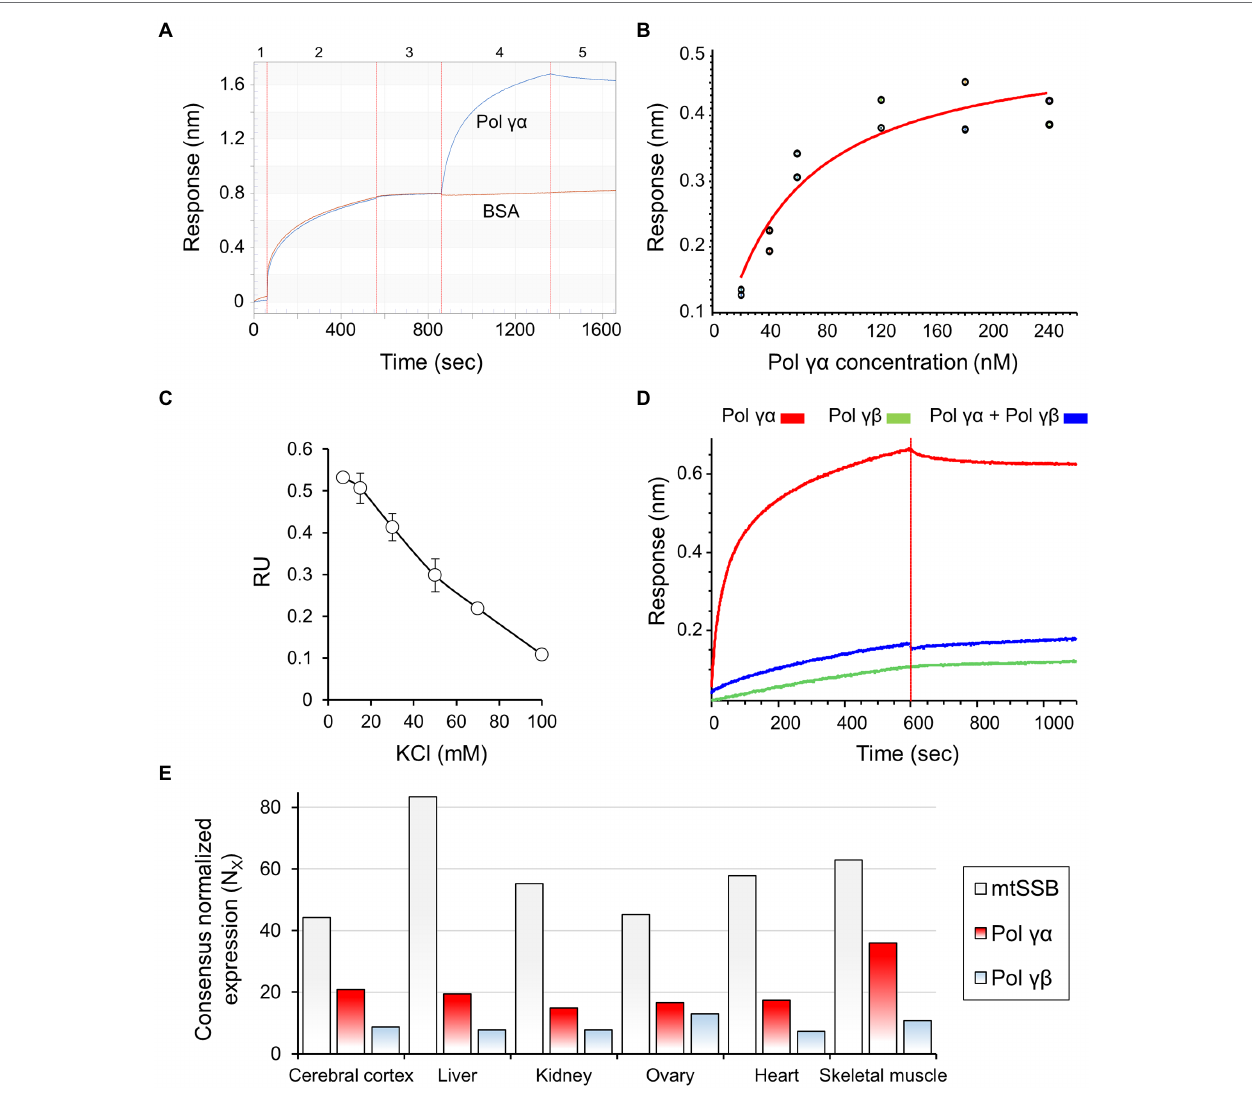
FIGURE 2 | mtSSB interacts physically with Pol γα but not Pol γ holoenzyme. (A) The affinity of mtSSB for Pol γα was assessed by biolayer interferometry (BLI), as described under Materials and Methods. A representative sensogram is shown, and the numbers atop indicate individual experimental steps. Briefly, hydrated biosensors (1) were saturated with mtSSB (2), blocked with BSA (3), and placed into solutions of Pol γα . The association of the proteins was measured in real-time for 5 min (4), after which the sensors were moved to a buffer to allow dissociation (5). Excess BSA was present in all solutions used in steps 3–5. (B) The binding affinity of mtSSB for Pol γα was determined by BLI, as described in (A) , using two sets of association responses upon increasing Pol γα concentrations (indicated), fitted to a 1:1 binding model (see also Supplementary Figure 2 ). (C) The effect of salt concentration on the stability of the Pol γα -mtSSB complex was assessed by measuring changes in the association response of 120 nM Pol γα in the presence of increasing KCl concentrations. (D) The association of Pol γβ with mtSSB, and its effect on the mtSSB-Pol γα binding, was assessed as described in (A) , replacing or preincubating 120 nM Pol γα with 120 nM Pol γβ 2 , as indicated. (E) The data representing the consensus transcript expression values (N X ) of Pol γα , Pol γβ , and mtSSB in selected tissues, were obtained from Human Protein Atlas. Pol γα corresponds to entry POLG (https://www.proteinatlas.org/ENSG00000140521-POLG/tissue); Pol γβ to entry POLG2 (https://www.proteinatlas.org/ ENSG00000256525-POLG2/tissue); mtSSB to SSBP1 (https://www.proteinatlas.org/ENSG00000106028-SSBP1/tissue). The Consensus Normalized eXpression (NX) levels were created by the Human Protein Atlas team, by combining the data from the three transcriptomics datasets (HPA, GTEx, and FANTOM5) using the internal normalization